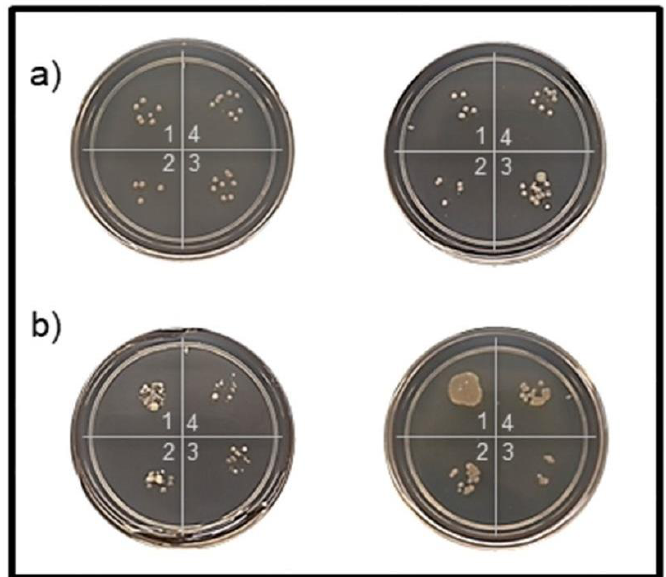
Figure 8. Disinfection of Long Island Sound (LIS) surface water under 365 nm UV light ( a ) without the presence of the nanocomposite and ( b ) with the presence of 5 mg/mL of annealed MS-TiO 2 -10 (8.7 wt.% Ti) nanocomposite. 1 = untreated, 2, 3, 4 = after 20, 25, and 30 min treatments.